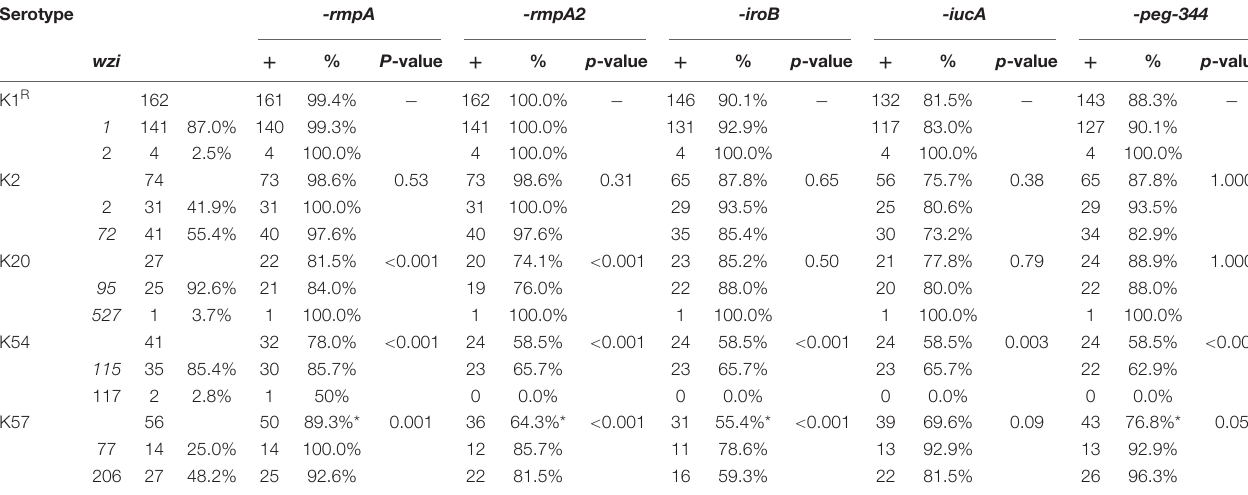
TABLE 3 | Distribution of virulence genes among capsular serotypes and major wzi types. Serotype